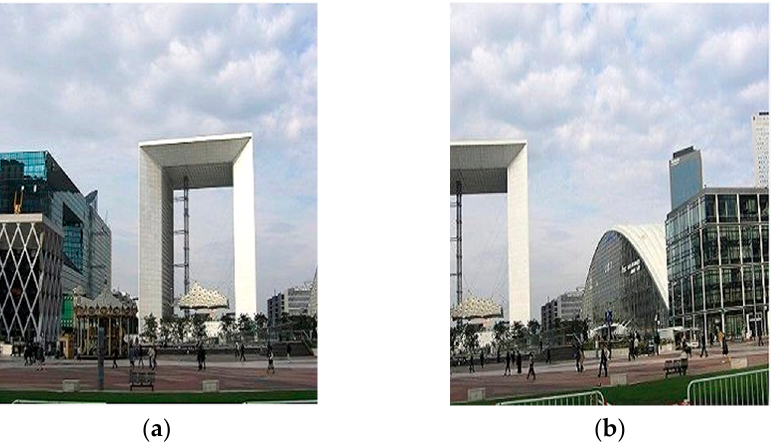
Figure 6. The improved images for T2: ( a ) Reference image; ( b ) Be-registered image.